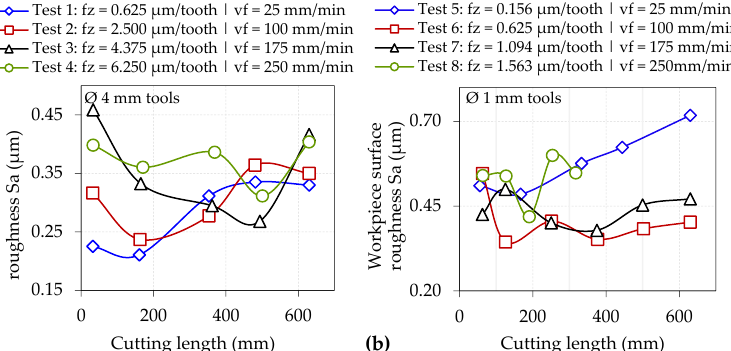
Figure 14. Workpiece surface roughness of slots machined using ( a ) Ø 4 mm and ( b ) Ø 1 mm end-mills.